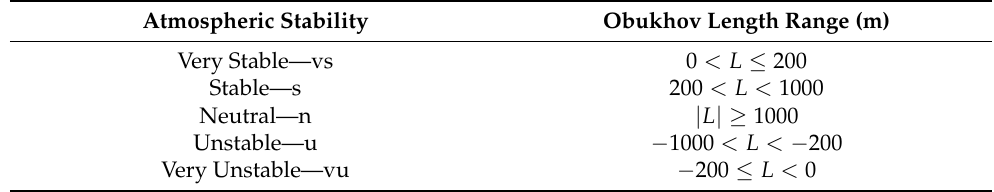
) as a function of Obukhov’s length for z = 25 m (thick Figure 2. Stability correction function Ψ m ( z L solid line) and z = 83 m (dashed line). The vertical grey shaded area delimits the interval from L = − 50 to L = 10 m. Vertical lines delimit Gryning et al. [51] stability classification thresholds per Table 3. Labels: vu, very unstable; u, unstable; nnu, near-neutral unstable; n, neutral; nns, near-neutral stable; s, stable; and vs, very stable. Table 2. Van Wijk et al.’s stability classes based on the Obukhov length, L . Adapted from [50].